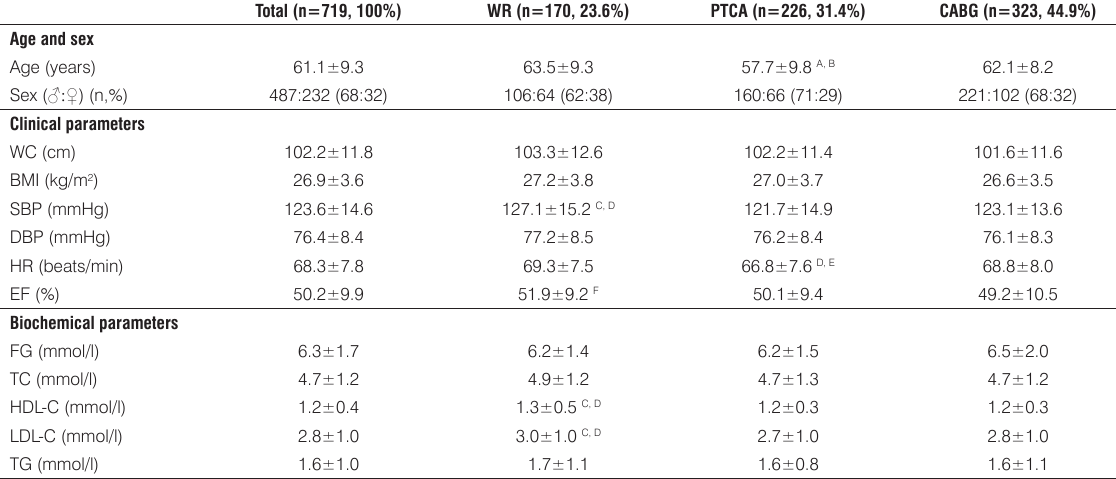
Table 1. Clinical and biochemical characteristics.